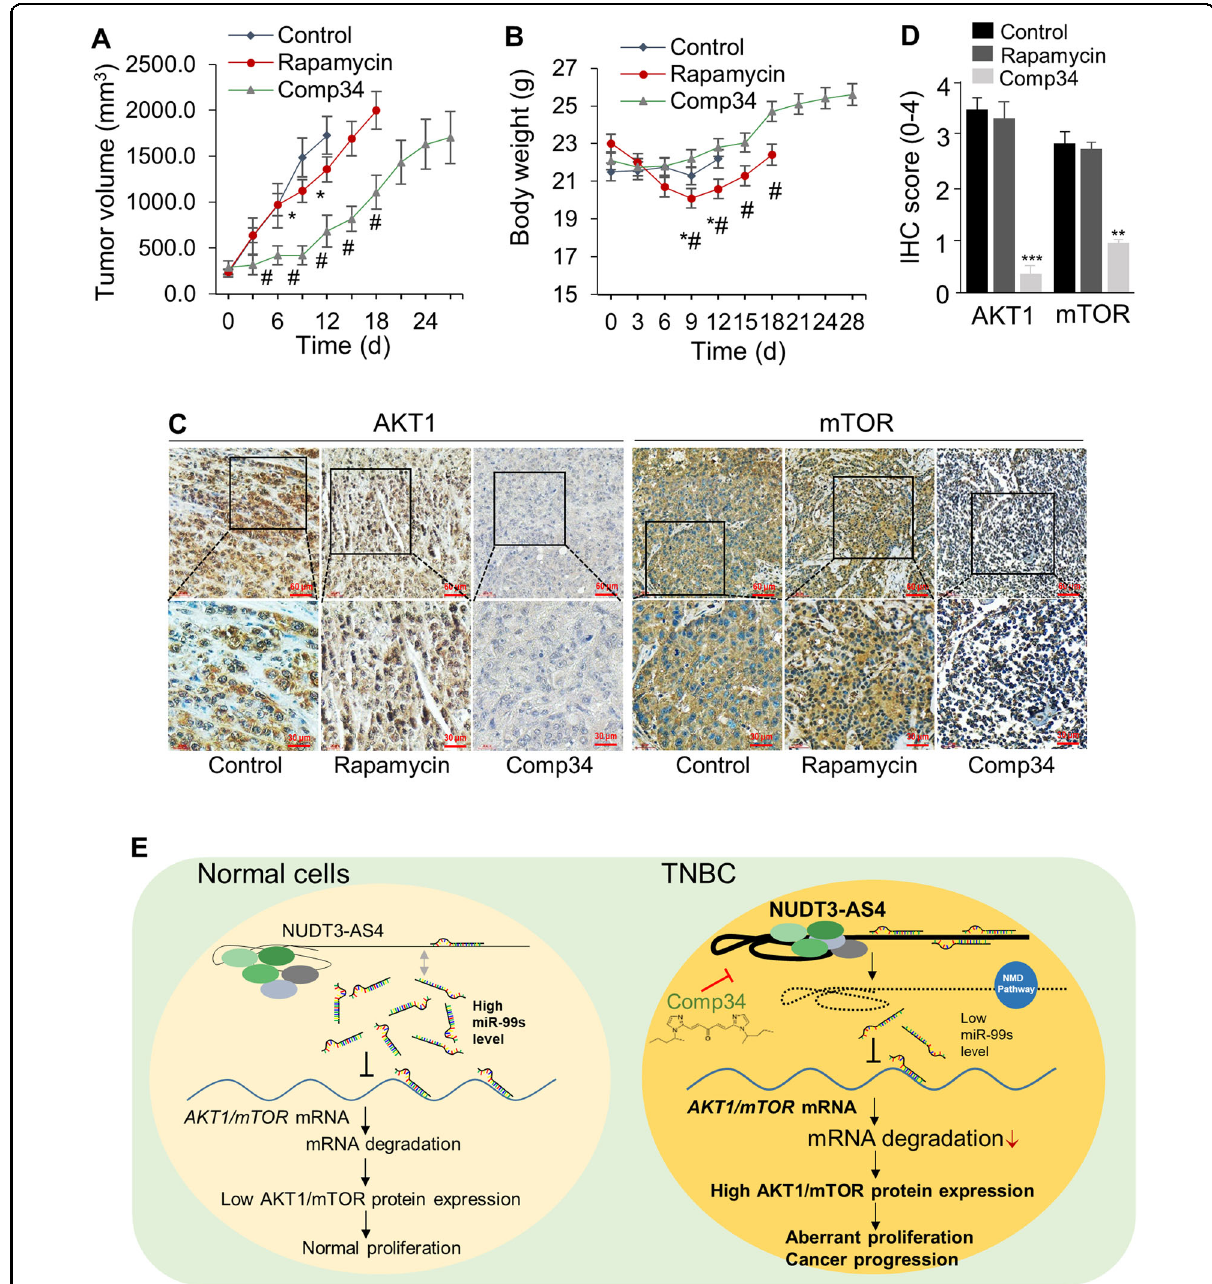
Fig. 7 Effect of Comp34 on tumor growth in vivo. a Tumor volume of MDA-MB-231 cells transplanted into female athymic nude mice (nu/nu) and treated with vehicle ( n = 10), rapamycin (5 mg/kg, i.p., n = 12), or Comp34 (5 mg/kg, i.p., n = 12) once every 2 days for 4 weeks. b body weight was checked every 3 days. * P < 0.05 versus control; # P < 0.05 versus rapamycin. c Paraf fi n sections of xenograft tumor tissues were subjected to immunohistochemical (IHC) staining using the antibodies indicated. d Staining score of IHC analysis of AKT1 and mTOR. p value was calculated by one-way ANOVA. *** p < 0.001 vs control. e The identi fi ed signaling pathway in this study indicated that Comp34 represses TNBC growth via inhibition of AKT1/mTOR mRNA and protein expression. Long noncoding RNA (lncRNA) -NUDT3-AS4 acts as a microRNA sponge to compete with AKT1/mTOR mRNAs for binding to miR-99s, leading to decrease in degradation of AKT1/mTOR mRNAs and subsequent increase in AKT1/mTOR protein expression, which promotes TNBC growth and progression. Comp34-induced miR-99s dissociation from NUDT3-AS4 and resultant degradation of NUDT3-AS4 through the NMD pathway lead to increase in miR-99s-dependent degradation of AKT1/mTOR mRNA in TNBCs, subsequently inhibiting AKT1/mTOR protein expression and TNBC